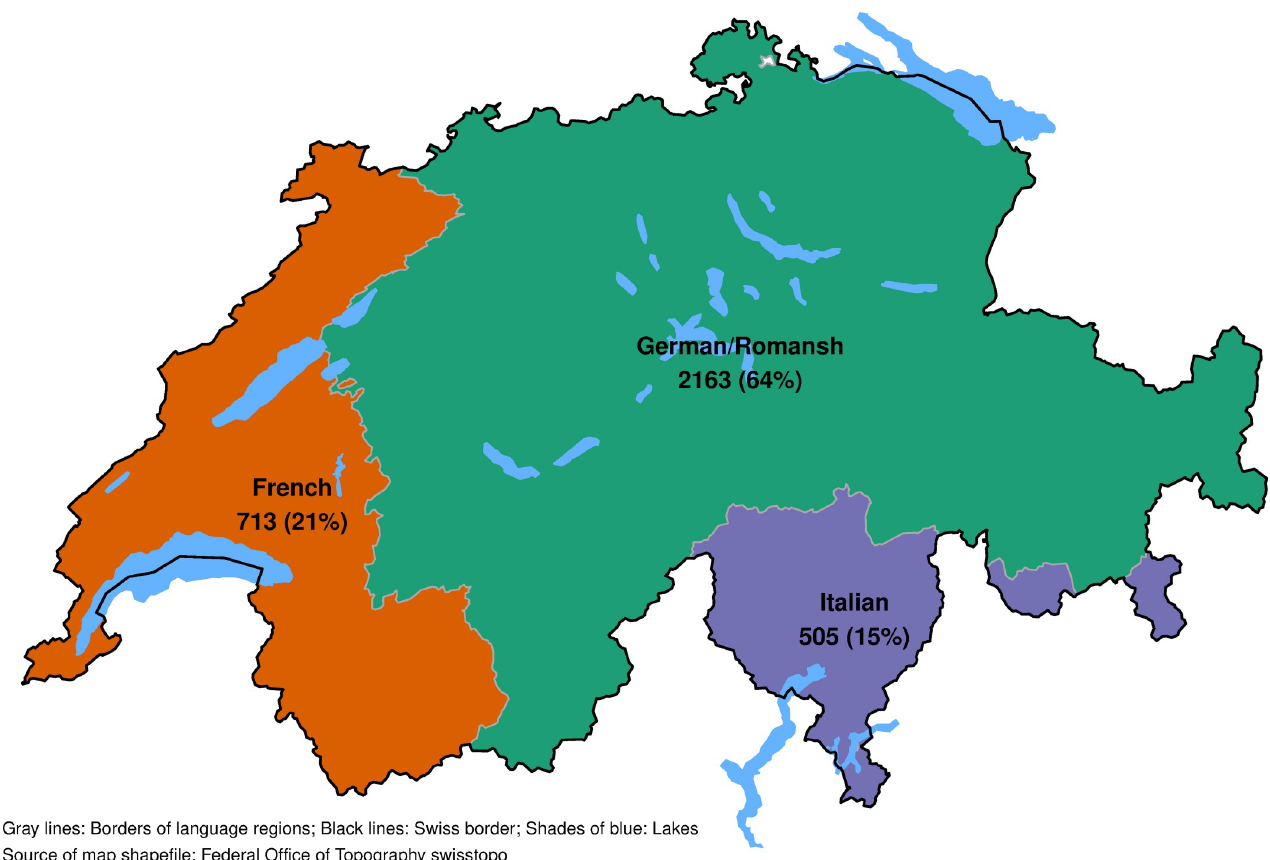
Fig 1. Number of survey participants, by language